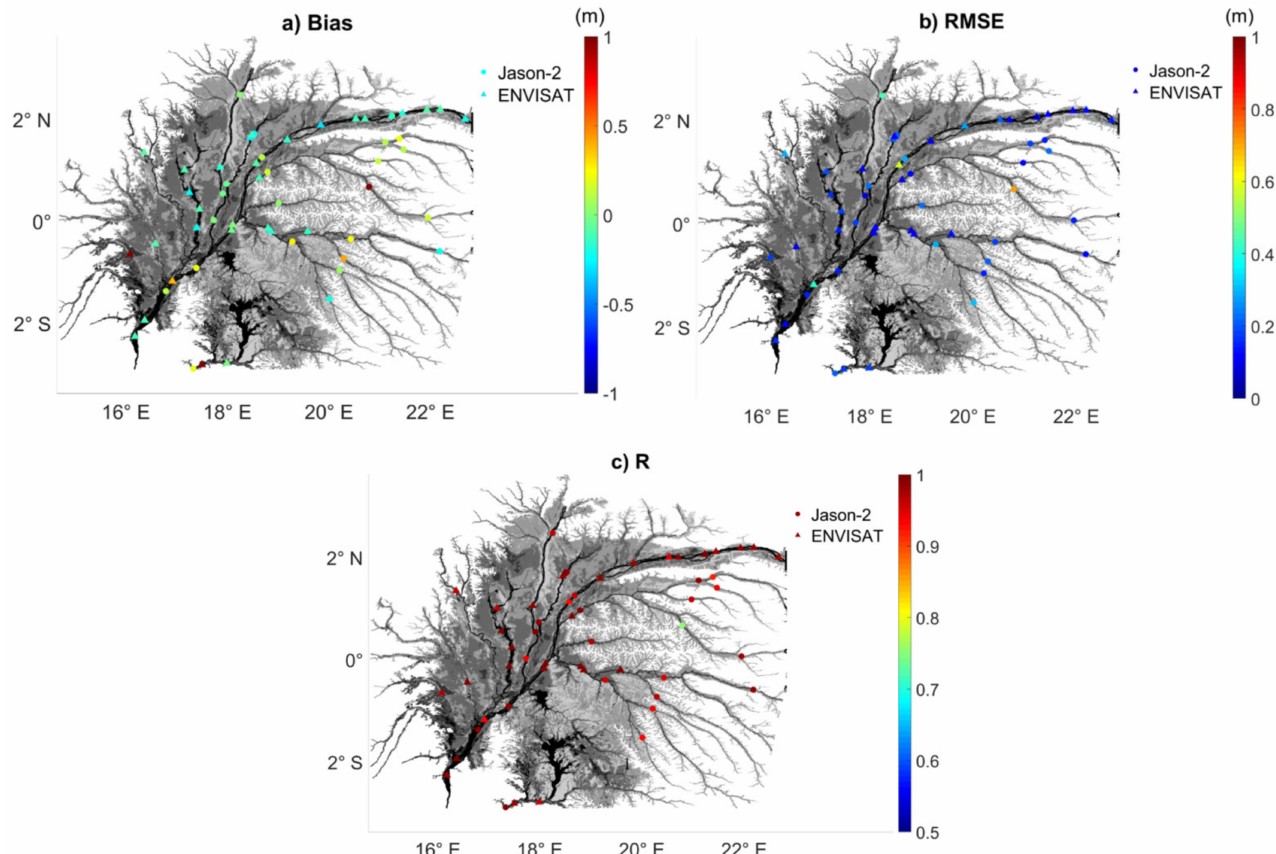
Figure 8. Comparison between altimetry-based of water levels from Hydroweb and automatically generated (this study) in terms of ( a ) bias, ( b ) RMSE and ( c ) r. VS locations are represented using either a dot (Jason-2) or a triangle